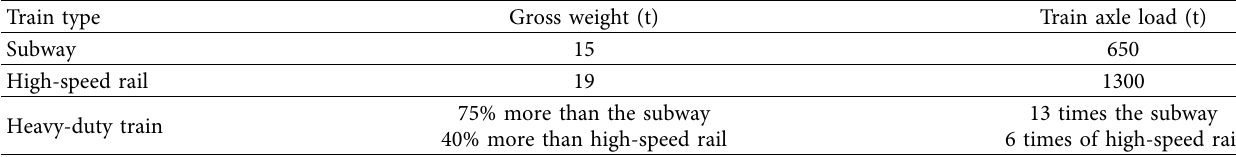
Table 1: Comparison of various train parameters.